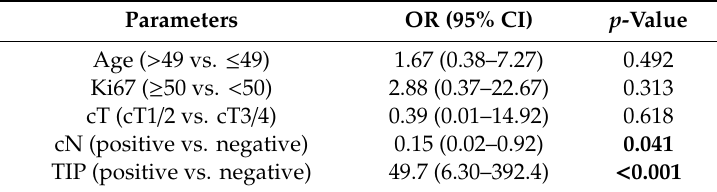
Table 5. Association between age, Ki67, cT, cN, TIP, and pCR.